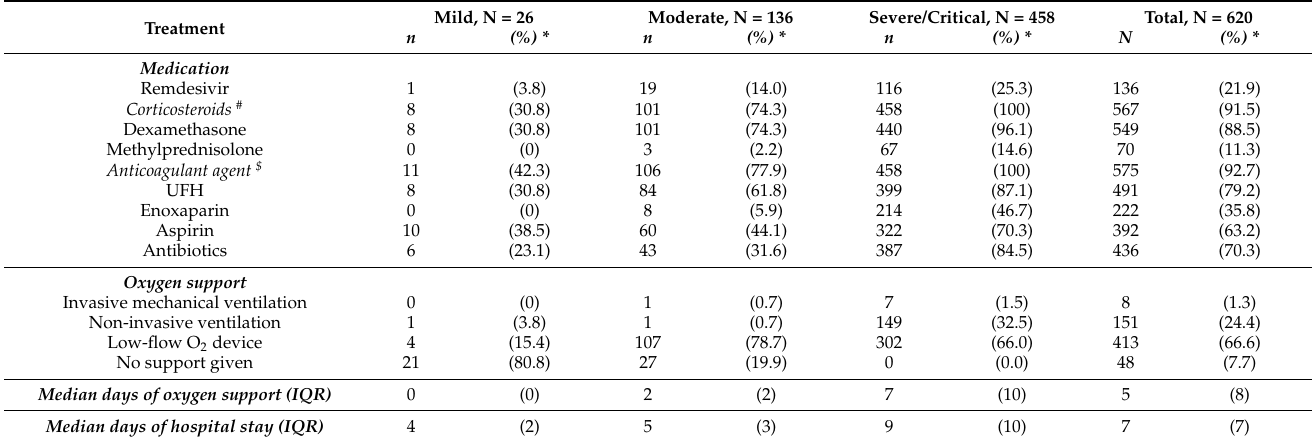
Table 4. Treatment administered to COVID-19 patients (stratified by severity of illness at the time of presentation) admitted in a tertiary hospital of Nepal from April to September